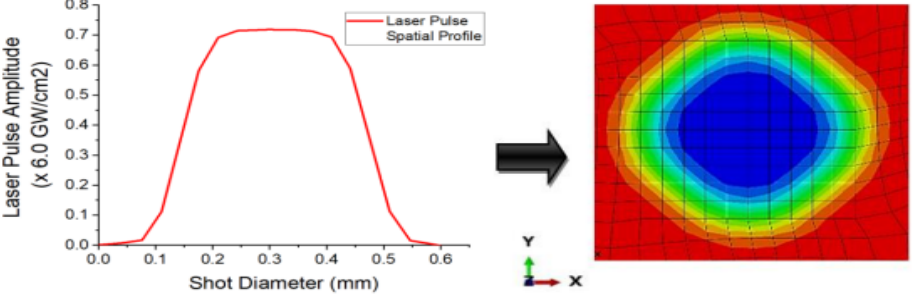
Figure 3. Laser shot spatial intensity distribution profiles.